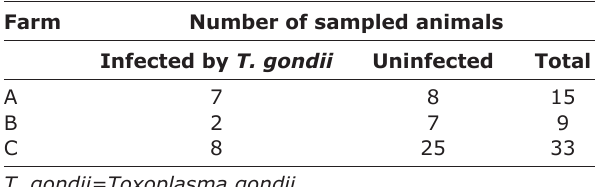
Table-2: Number of infected and uninfected animals sampled in each farm. Farm Number of sampled animals